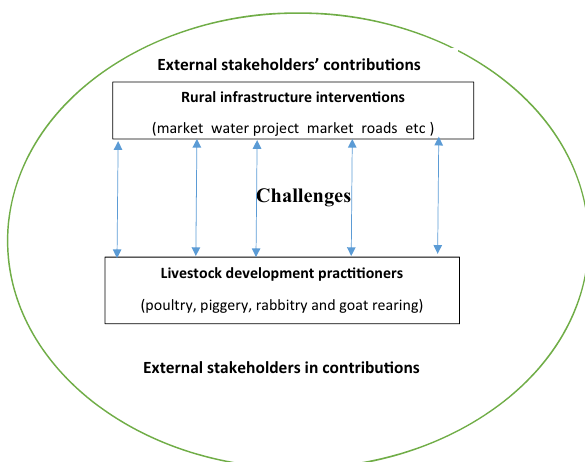
Figure 1: Conceptual framework for assessing contributions of sta - keholders to livestock development in Delta State, Nigeria through rural infrastructure